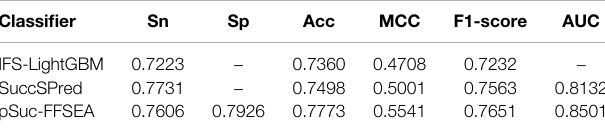
TABLE 6| Performance comparison ofpSuc-FFSEAwith other existing